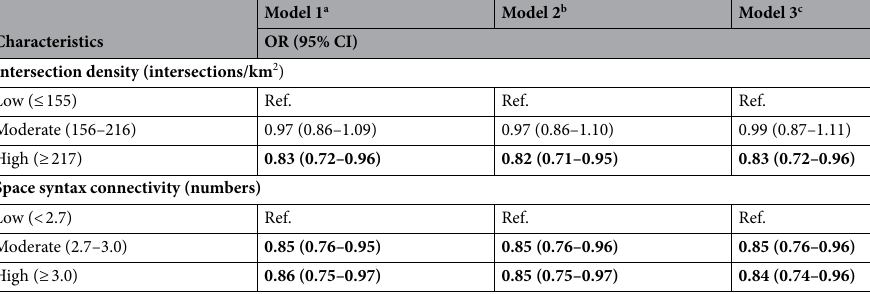
Table 2. Logistic regression results for associations between depression and explanatory variables (Model 1 a , Model 2 b , and Model 3 c ; for full tables see Supplementary Tables 2-1-1, 2-1-2, 2-1-3, 2-2-1, 2-2-2, 2-2-3). Ref. Reference group, OR Odds ratio, 95% CI 95% Confidence interval. p -Value = significant p values (< 0.05) are in bold. a Model 1 controlled for sex, age, education, equivalent household income, marital status, living situation, driving status, land value, and population density. b Model 2 controlled for sex, age, education, equivalent household income, marital status, living situation, driving status, land value, population density, frequency of going out, and duration of walking time. c Model 3 controlled for sex, age, education, equivalent household income, marital status, living situation, driving status, land value, population density, frequency of seeing friends, and social